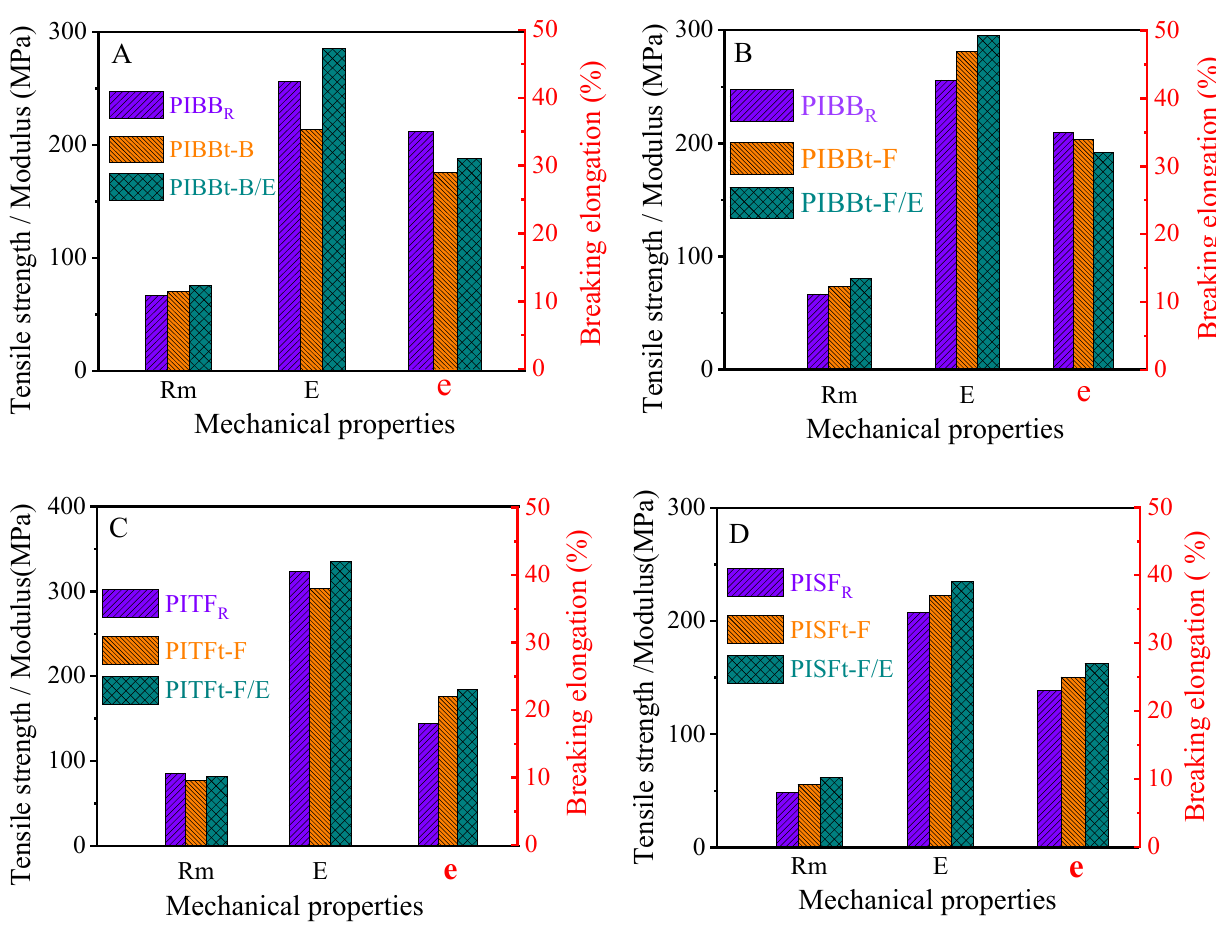
Figure 8. Tensile strength (Rm/MPa), tensile modulus (E/MPa), and elongation at break (e/%) comparison of the PI films capped with different blockers: ( A ) PIBB R /PIBB t-B /PIBB t-B/E ; ( B ) PIBB R /PIBB t-F /PIBB t-F/E ; ( C ) PITF R /PITF t-F /PITF t-F/E and ( D ) PISF R /PISF t-F /PISF t-F/E . Table 5. Mechanical properties of PIBBs, PITFs, and